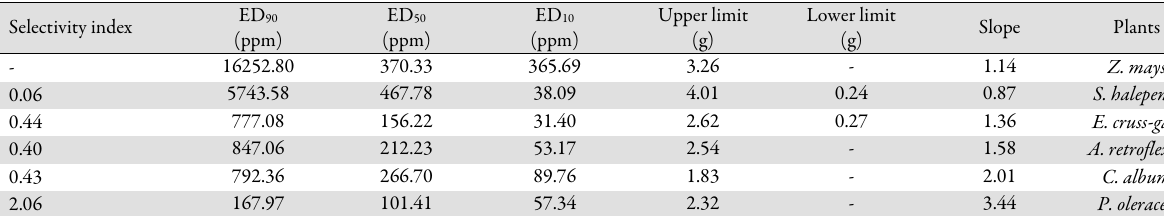
Table 2. Estimated parameters for the dose-response curves